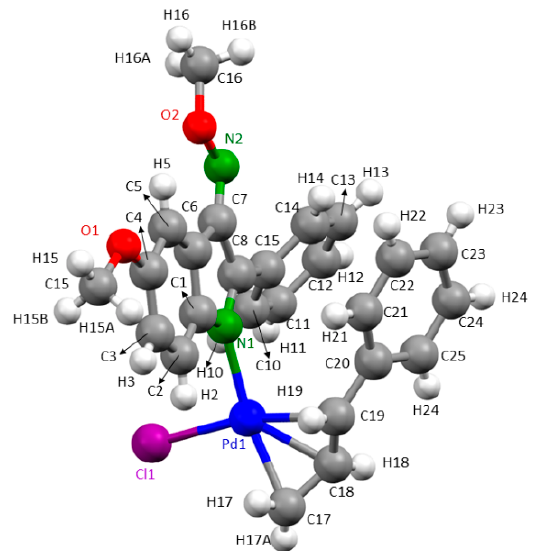
Figure 5. Molecular structure of [Pd( η 3 -1-PhC 3 H 4 ){C 8 H 3 N-2-(C 6 H 5 )-3NOMe-5(OMe)}Cl] ( 3a ). Selected bond lengths (in Å) and angles (in deg.): Pd1-Cl1, 2.3734(11); Pd1-N1, 2.115(2); Pd1-C17, 2.118(3); Pd1- C18, 2.118(3); Pd1-C19, 2.159(3); C18-C17, 1.384(5); C19-C18, 1.402(5); Cl1-Pd1-N1, 95.41(7); C19-Pd1-